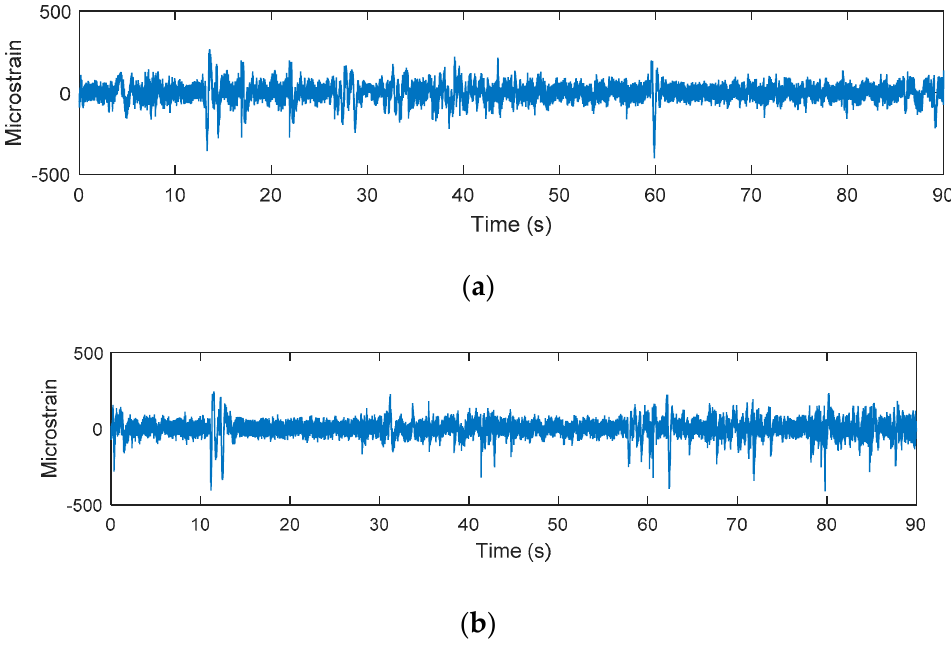
Figure 17. Measured strain signals: ( a ) Campus A, ( b ) Campus B. Table 2. Global statistic parameter for strain signals. Elastic-energy Model Measured Road Class